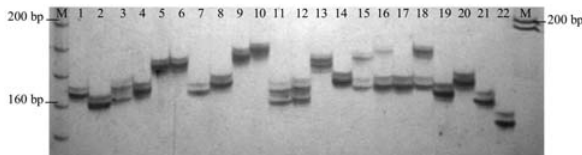
Figure 1 - Silver stained acrylamide gel (4% w/v). The observed pattern was obtained by the amplification of locus Ag171 in the following Arachis species: A. kretschmeri (1); A. subcoriacea (2 and 3); A. appressipila (4-6); A. vallsii (7); A. matiensis (8); A. aff. matiensis (9); A. lignosa (10); A. pflugeae (11-18); and A. hassleri (19) of the section Procumbentes and A. guaranitica (20 and 21) and A. tuberosa (22) of the section Trierectoides . Note the presence of heterozygous plants (12, 15 and 18) and also species from different sections sharing the same allele (14 and 20).